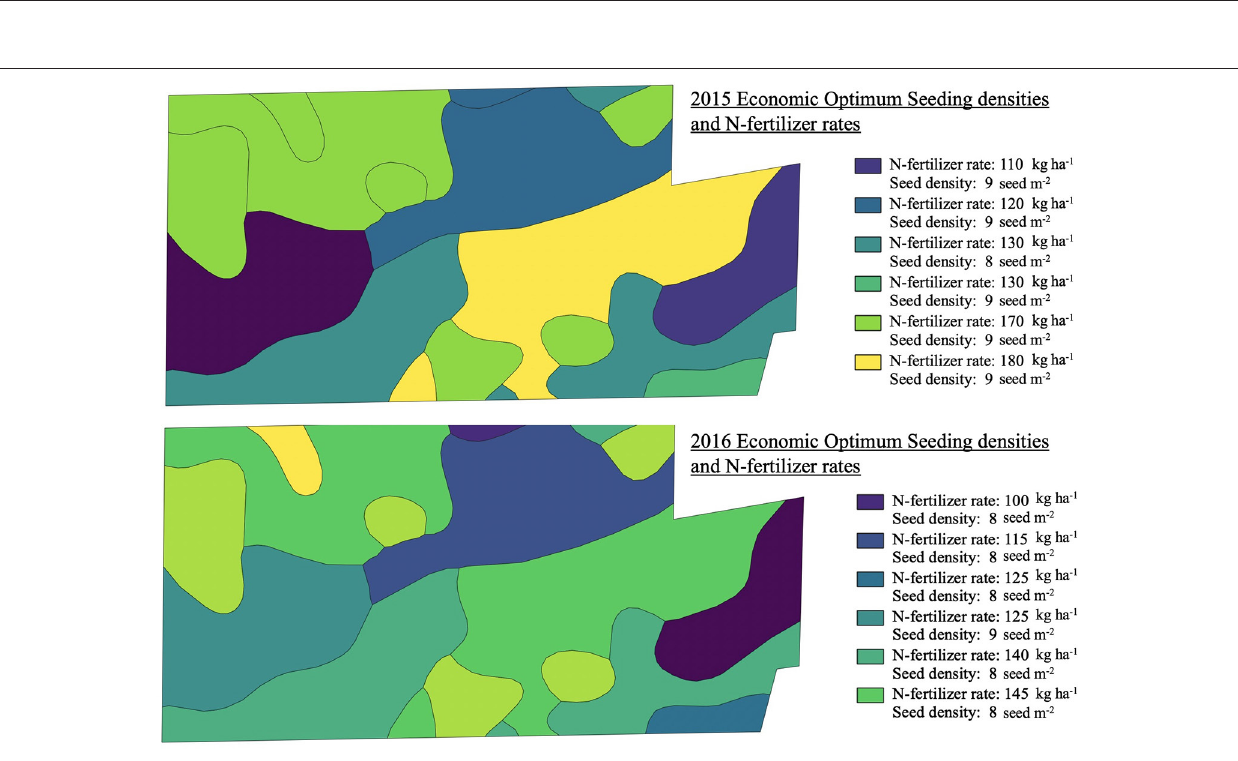
Frontiers in Sustainable Food Systems |